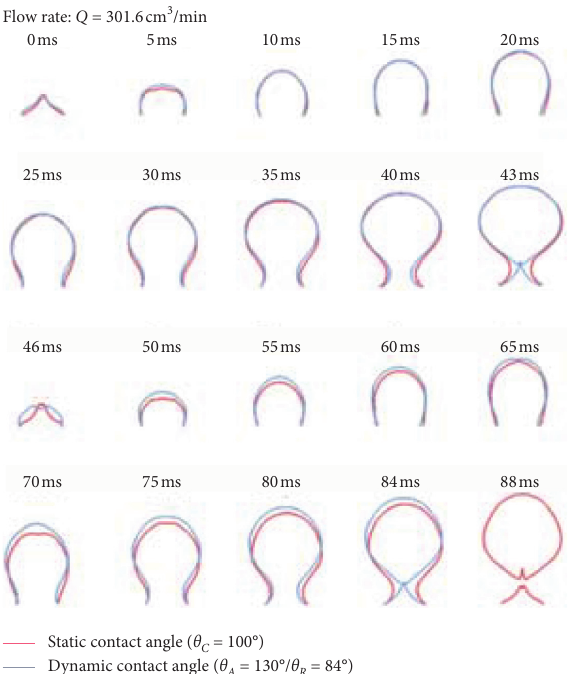
Figure 7: Comparison of profile between dynamic and static contact angle models ( Q � 301.6 cm 3 /min, Re � 109.54, and d bubble: 0–43 ms (46ms for the static contact angle model); second bubble: 46–84ms (88ms for the static contact angle model); advancing contact angle period: 0–20ms for the first bubble and 46–65ms for the second bubble; receding contact angle period: 20–40ms for the first bubble and 65–80ms for the second bubble.